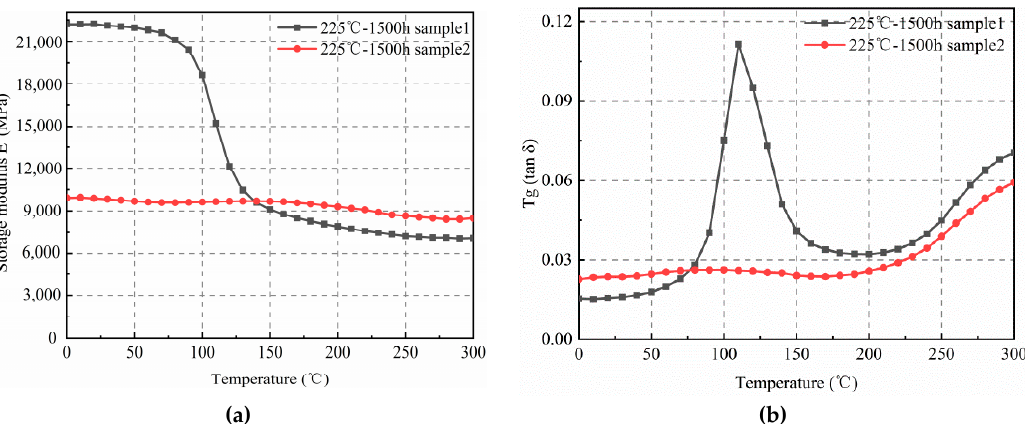
Figure 7. Elasticity modulus and T g of samples after 1500 h of high-temperature aging at 225 ◦ C. ( a )